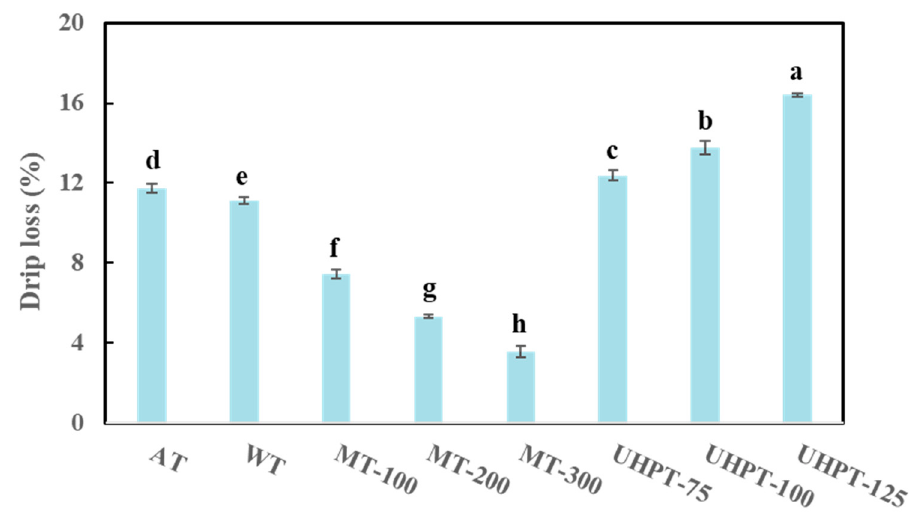
Figure 4. The drip loss of thawed mangoes that were affected by different thawing conditions. The different lowercase letters mean the significant difference among thawing conditions ( p < 0.05).